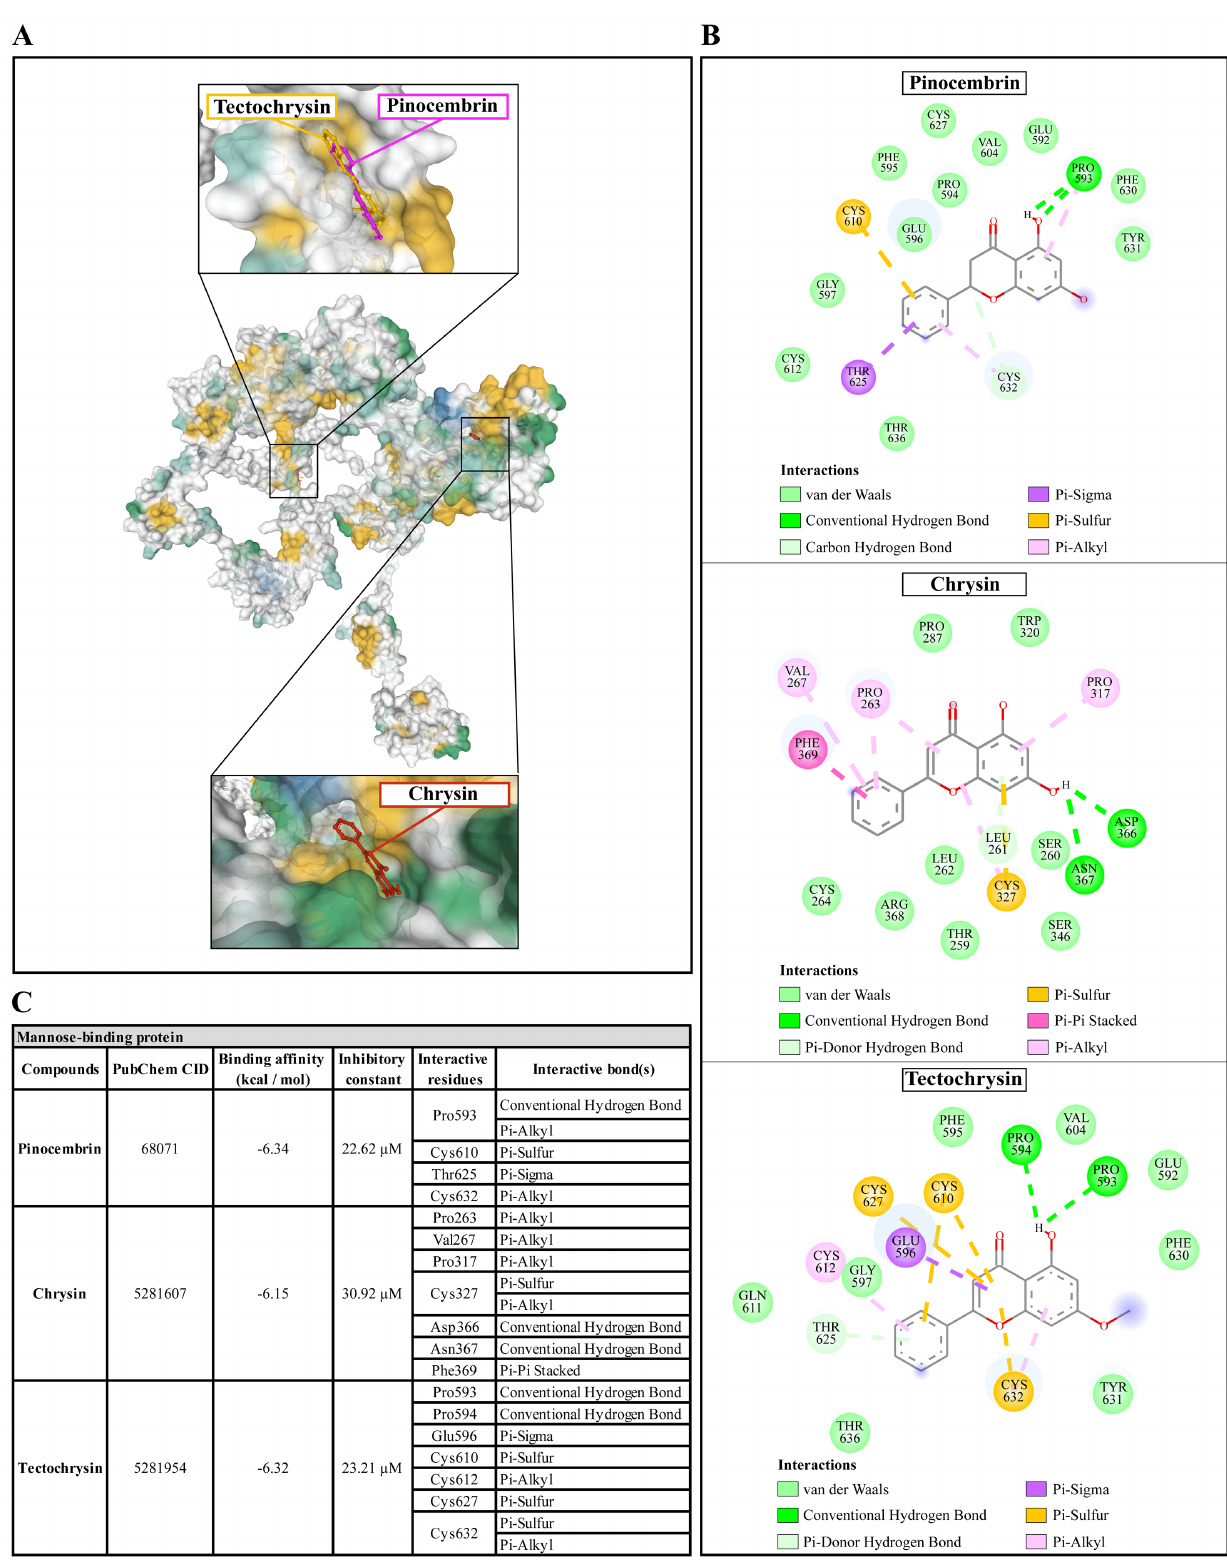
Figure 5. The interaction of pinocembrin, chrysin, and tectochrysin toward the AcMBP protein predicted by molecular docking. ( A ) Binding site of the ligands toward the AcMBP protein, purple compound represents pinocembrin, red compound represents chrysin, yellow compound represents tectochrysin. ( B ) A schematic representation of the detailed interactions of the ligand atoms with the protein residues. ( C ) Binding affinity and inhibitory constant prediction of propolis compounds against mannose-binding protein of Acanthamoeba castellanii . AcMBP, A. castellanii mannose-binding